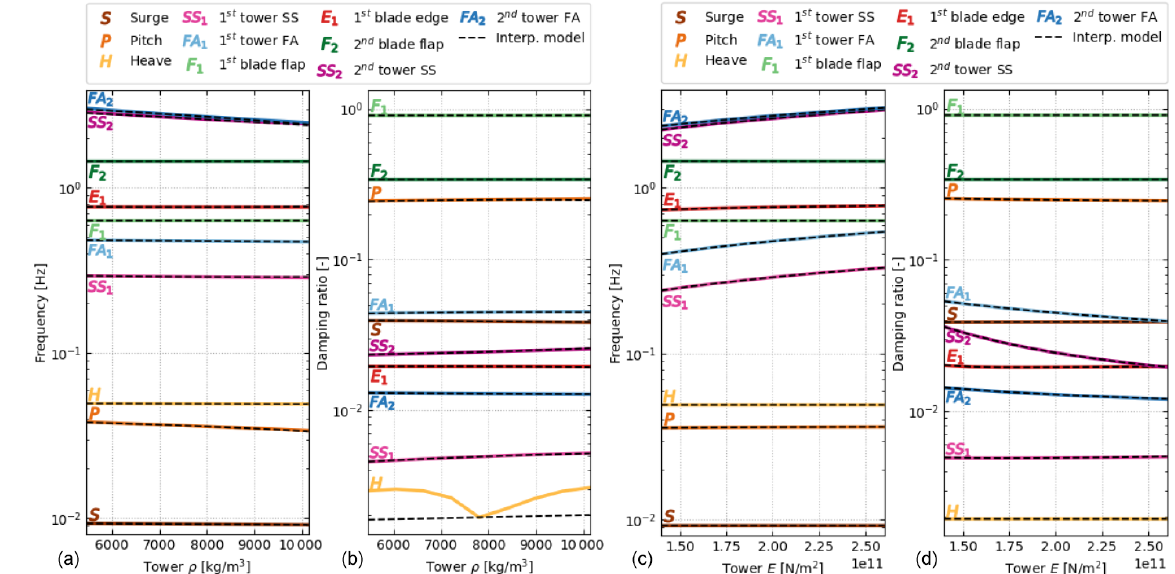
Figure 3. Variation of the system damped frequencies and damping ratios as a function of tower properties evaluated using the direct method (plain lines) and the interpolation method (dashed lines). (a, b) Variation of the tower density, ρ . (c, d) Variation of the tower Young modulus, E .